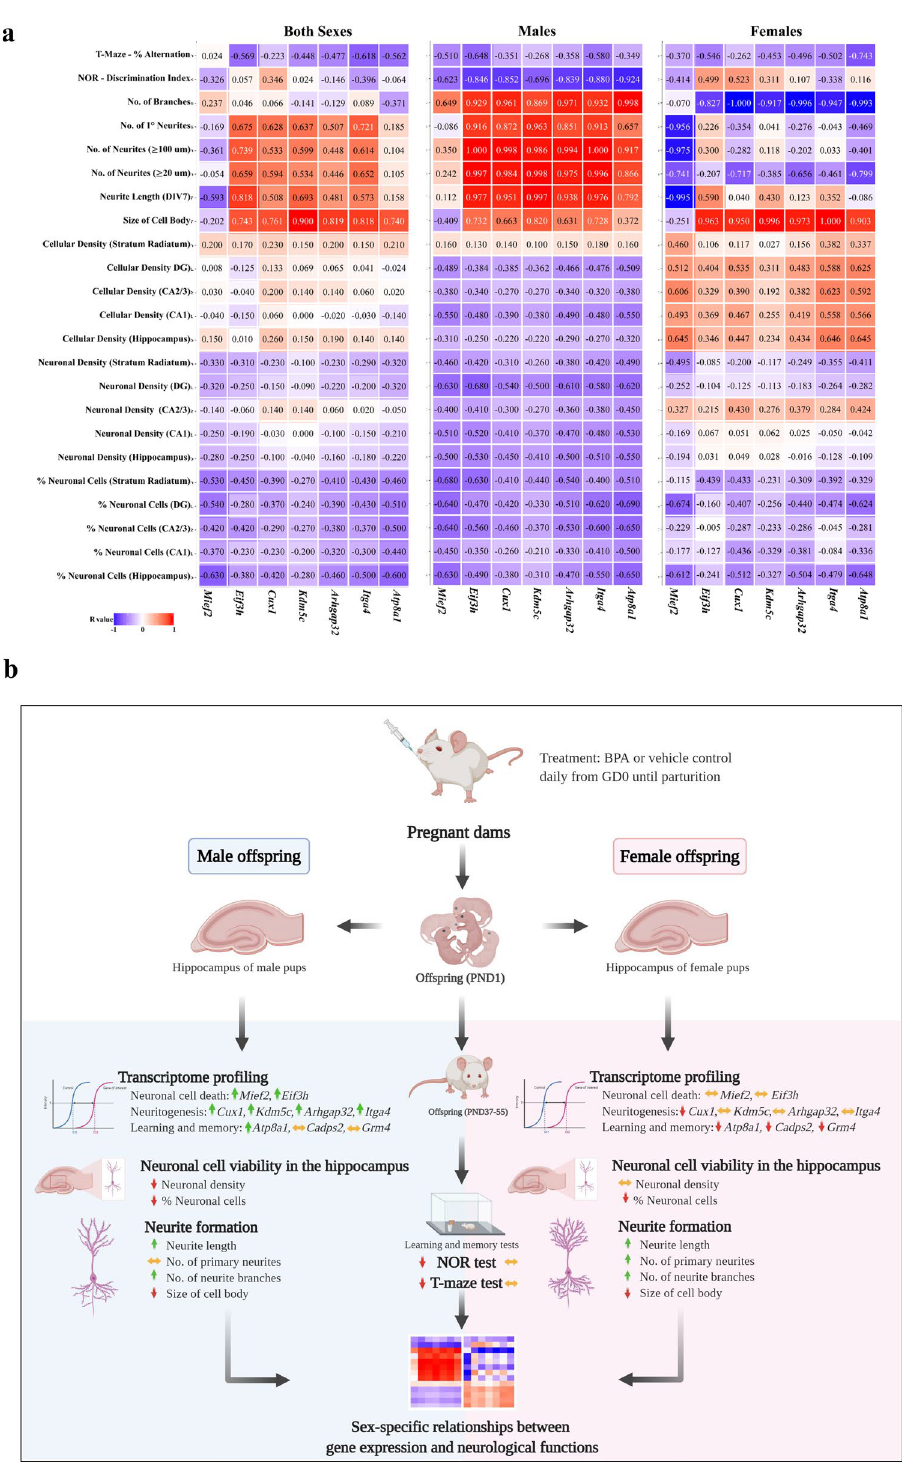
Figure 8. Heatmap of the correlation matrix between gene expression levels and neurological phenotypes, and schematic illustration of the main findings. ( a ) Correlation heatmap of the correlations between the expression levels of Mief2 , Eif3h , Cux1 , Kdm5c , Arhgap32 , Itga4 , and Atp8a1 and neurological functions. Color scale denotes R 2 from red (positive correlation) to blue (negative correlation). ( b ) A schematic diagram